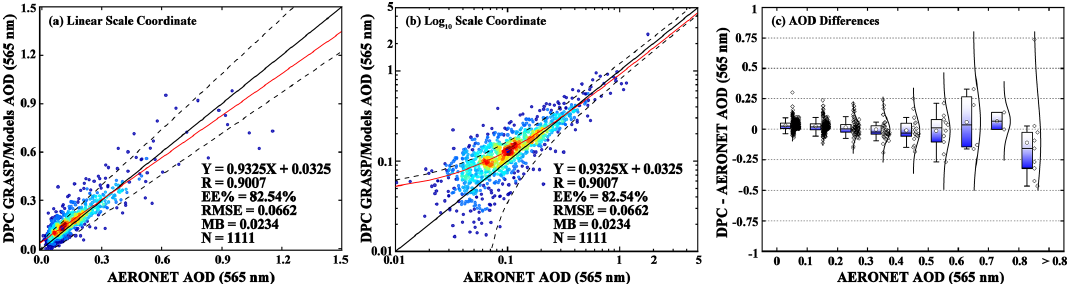
Figure 4. (a) Density scatterplot of AOD retrievals from DPC with the GRASP/Model scheme versus the AERONET observations with a logarithmic coordinate system after quality control. (b) The density scatterplot with a logarithmic coordinate system. The solid black lines are diagonal and the dashed black lines show the ranges of expected error. The solid red lines represent the linear regression line. (c) Box plots show changes in differences between the DPC GRASP/Model scheme and AERONET with AOD increasing. Diamonds and curves represent the distributions of samples and normal distribution fitting lines, respectively.